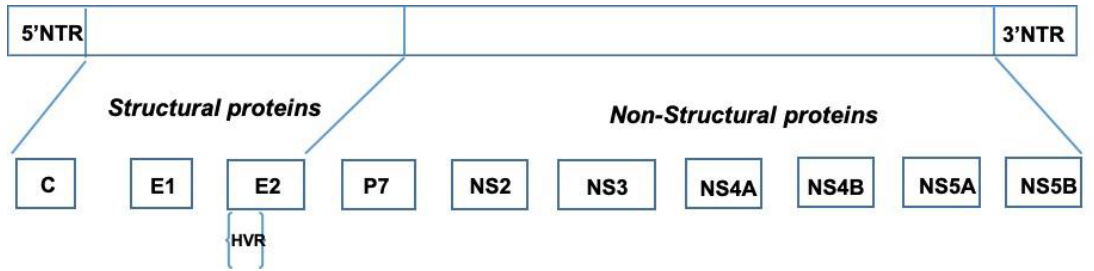
Figure 1. Diagrammatic representation of the 9.6 kb positive stranded RNA genome (top panel) and structural and non-structural proteins (lower panel).